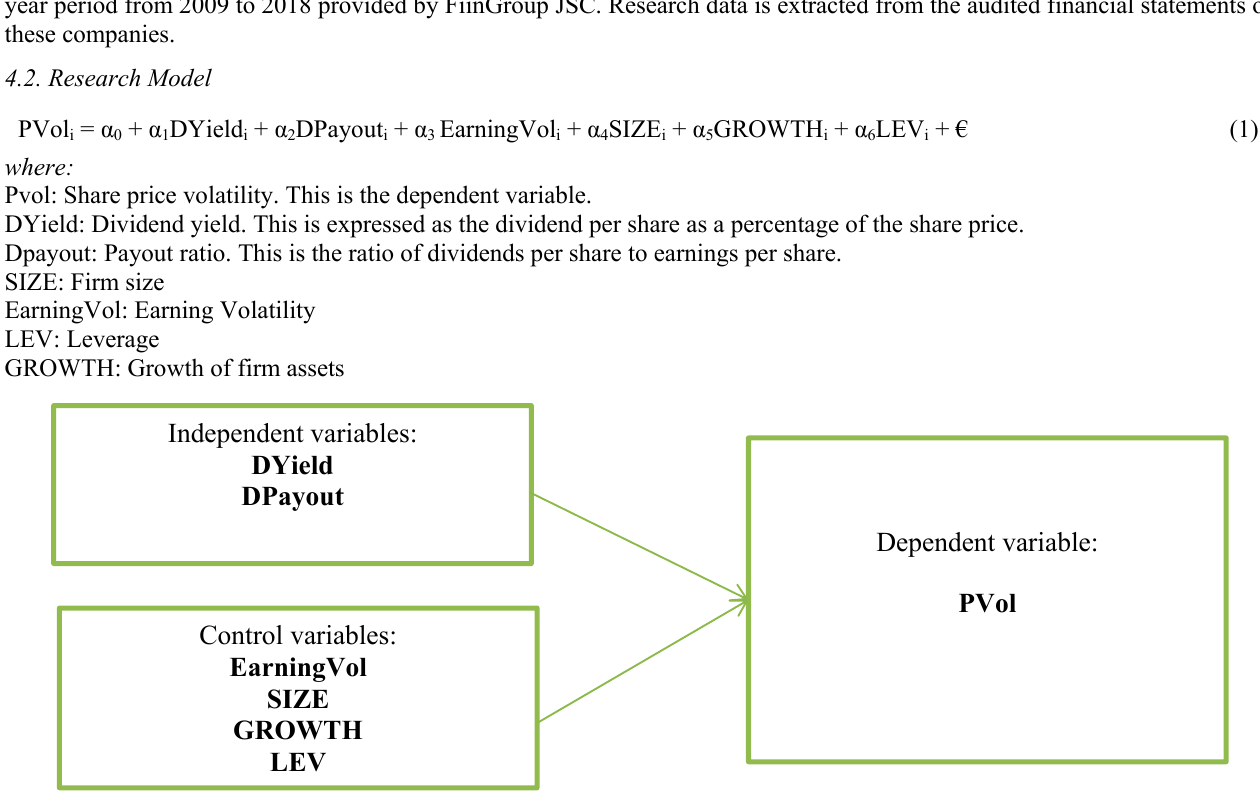
Fig. 1 . Research Model (Source: Compiled by the